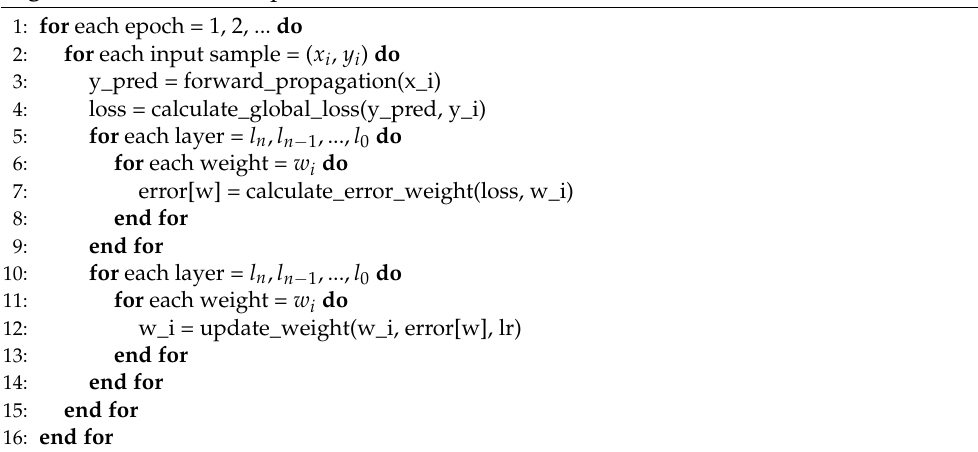
Algorithm 1 Baseline implementation of SGD.